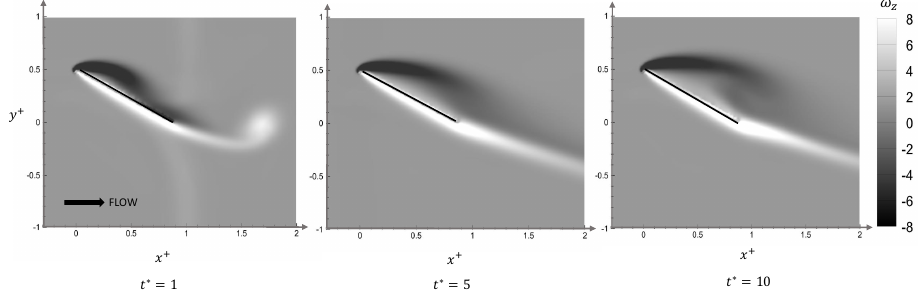
Figure 7. Contours of spanwise component of vorticity magnitude ( ω ∗ z ) at xy -plane ( z = 0) for 3D stationary panel at α = 30